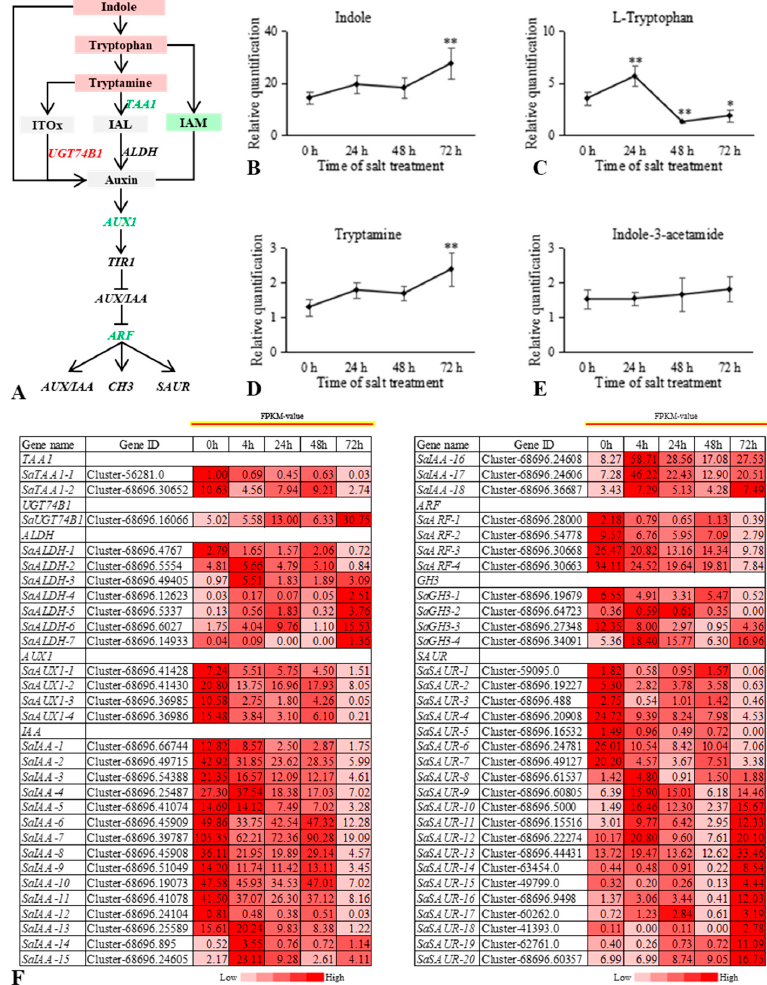
Figure 4. Overview of the relationship between differentially expressed genes (DEGs) and differential metabolites (DMs) in the auxin signaling pathway of Sophora alopecuroides under salt stress. ( A ) Overview of auxin signaling pathway. ( B – E ) The trend in the auxin signaling pathway DM changes with salt stress. Expression scores are shown as fold change. The horizontal axis represents the duration of salt treatment, and the vertical axis represents the relative quantification of metabolites (peak area × 10 6 ). Expression levels of six independent samples of metabolites and the control were compared by t -test, where ** represents p < 0.01 and * represents p < 0.05. ( F ) Heat map of auxin signaling pathway-related gene expression. Values are average fragments per kilo base per million mapped reads (FPKM) values of each sample in each group. ALDH, aldehyde dehydrogenase (NAD+); ARF, auxin response factor; AUX1, auxin influx carrier (AUX1 LAX family); IAA, auxin-responsive protein IAA; IAL, indole-3-acetaldehyde; IAM, indole-3-acetamide; ITOx, indole-3-thiohydroximate; SAUR, SAUR family protein; GH3, auxin responsive GH3 gene family.